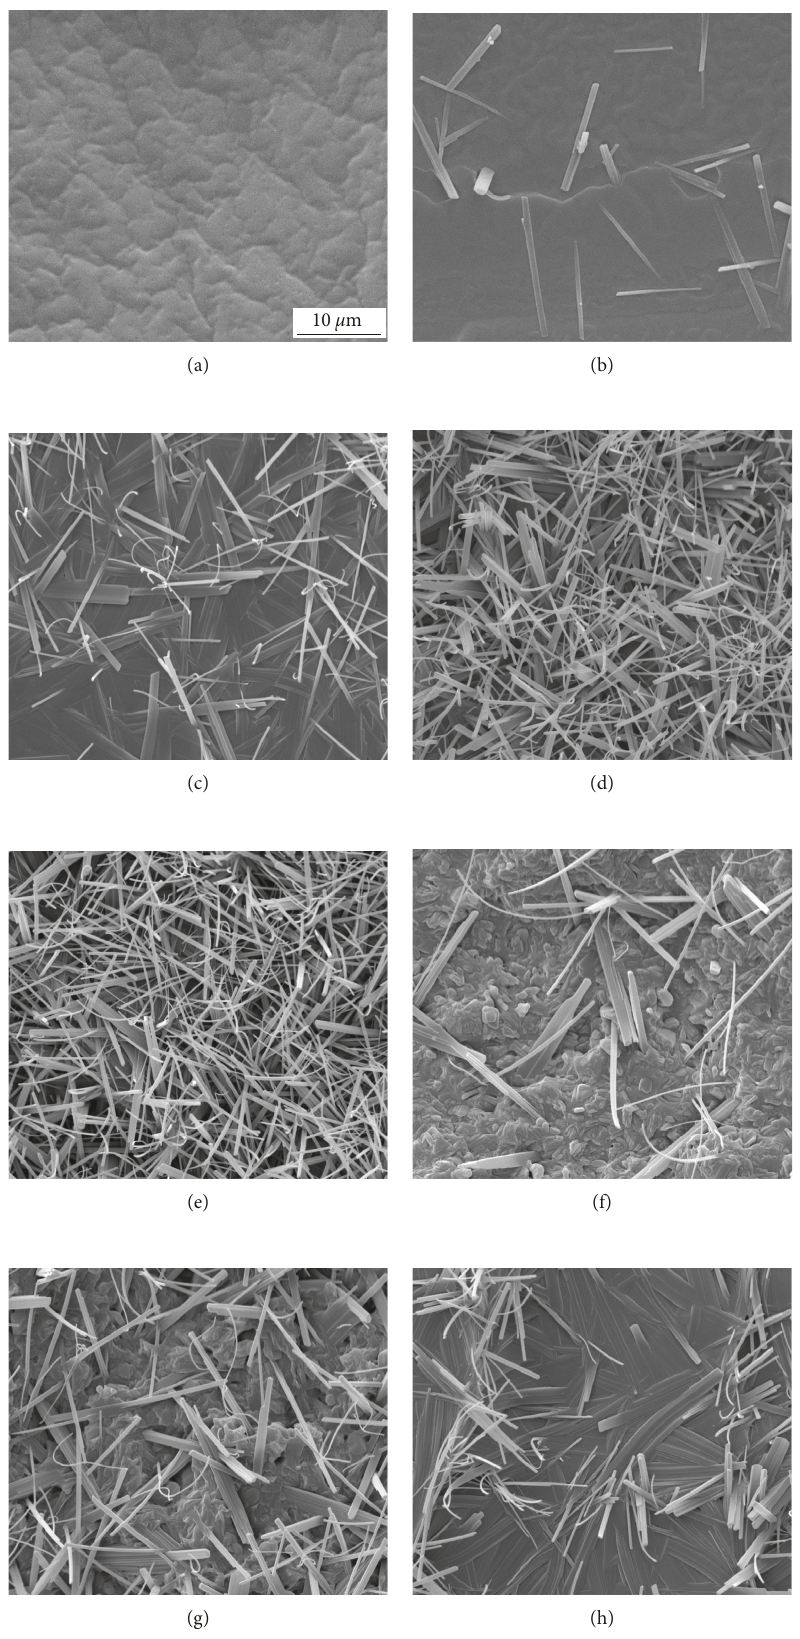
Figure 1: SEM images of fracture surfaces of (a) TPU and 328-composites with different mass ratios of 328: (b) 10%, (c) 20%, (d) 25%, (e) 30%, (f) 40%, (g) 50%, and (h)